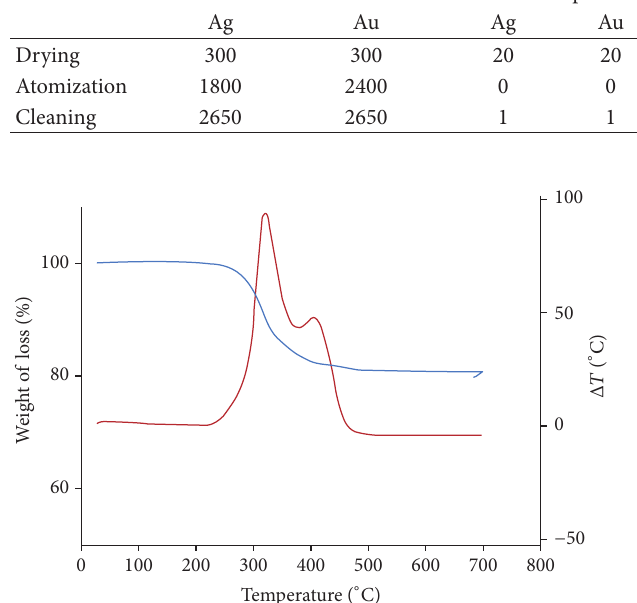
F3:TGandDTAcurvesofTREN-functionalizedFe